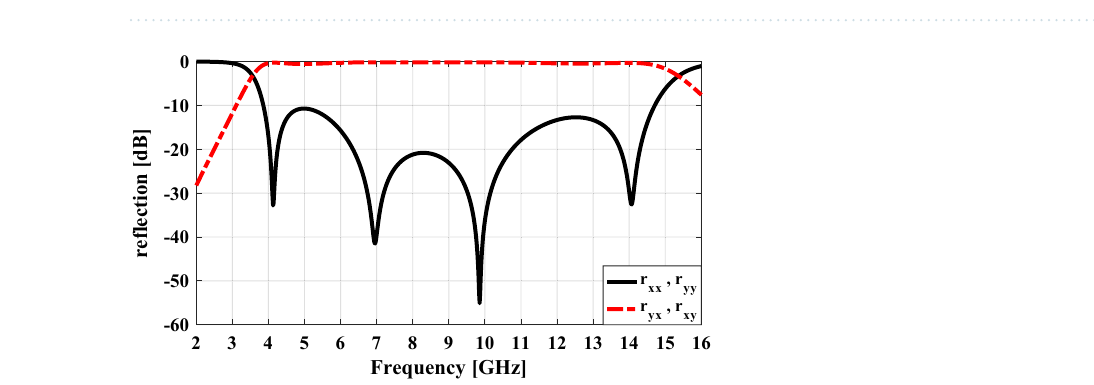
Figure 3. Surface current distributions on the resonator part and ground sheet of the basic unit cell. ( a ) 6.7 GHz eigenmode (i), ( b ) 14.8 GHz eigenmode (iii), ( c ) 3.8 GHz eigenmode (ii), and ( d ) 11.2 GHz eigenmode (iv).